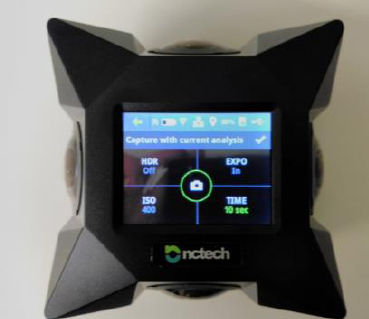
Figure 6. “Capture with current analysis” iSTAR mode activated.